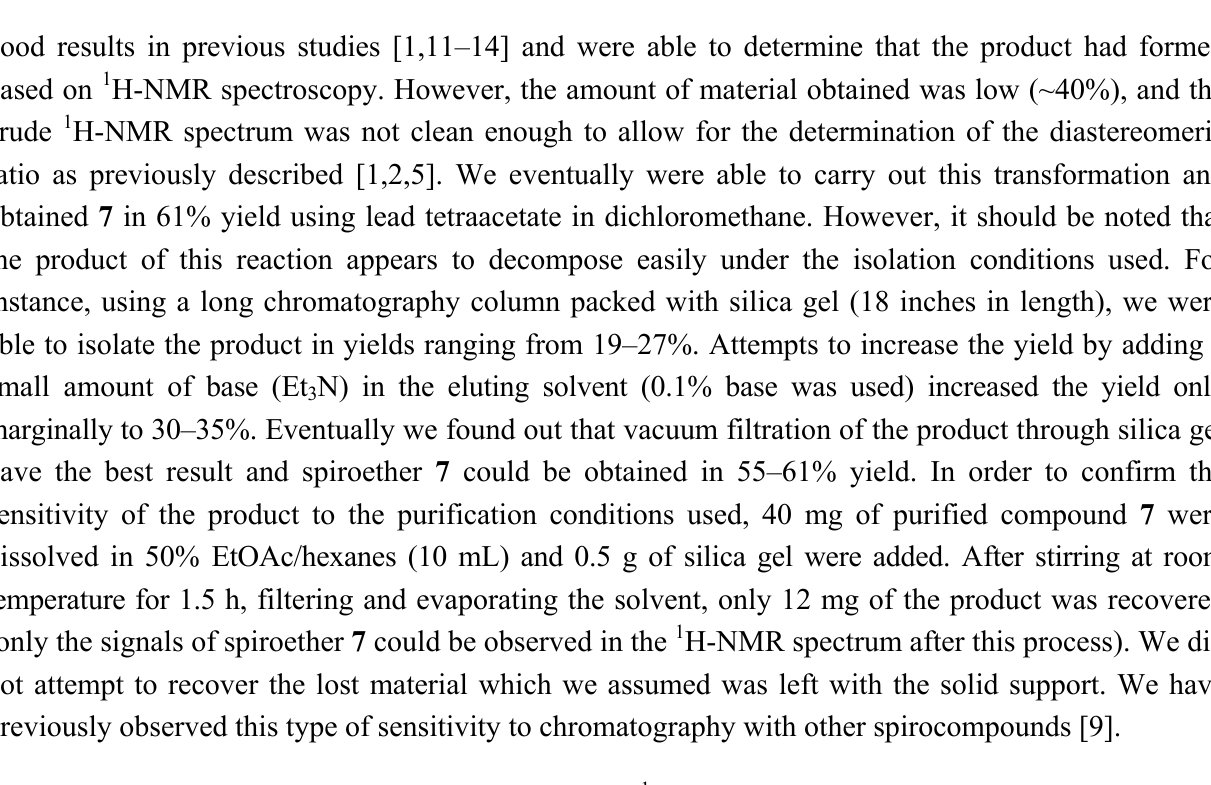
Figure 2. Characteristic portion of the crude 1 H-NMR spectra of spiroether 1 ( a ) and spiroether 7 ( b